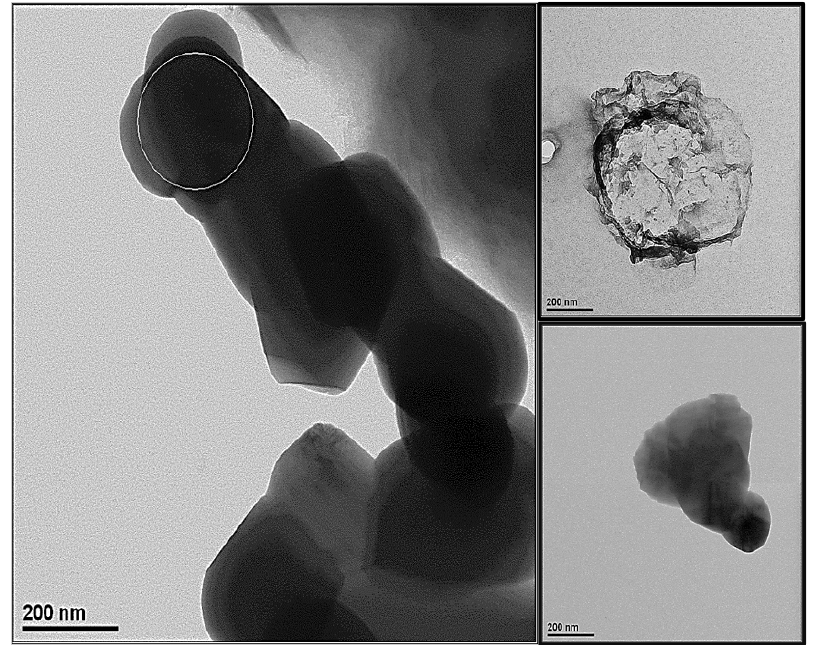
Figure 3. TEM images of hydroxyapatite derived from eggshell waste.